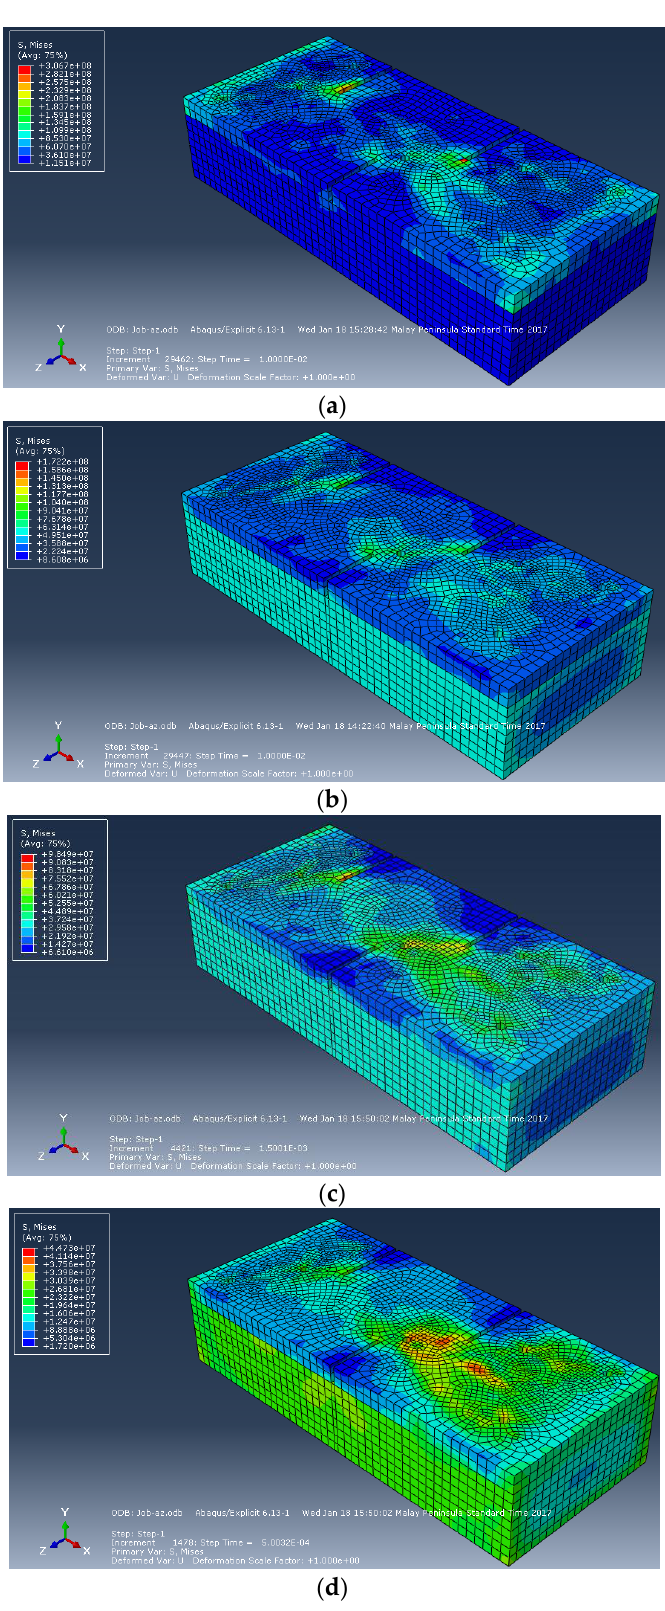
Figure 6. FE modeling of mechanical stress buildup of corrosive AZ31 alloy at temperatures: ( a ) 300 K; ( b ) 350 K; ( c ) 400 K; and ( d ) 450 K. It can be seen that, regardless of temperature, the stress concentration is highest at corrosive film near pits and crack tips which leads to material deterioration.